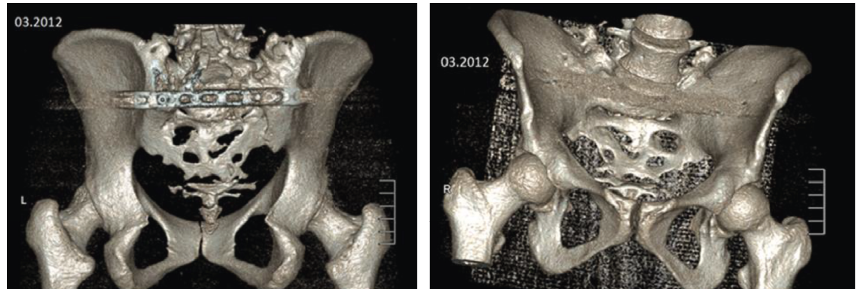
Figure 9: 3D reconstruction of the